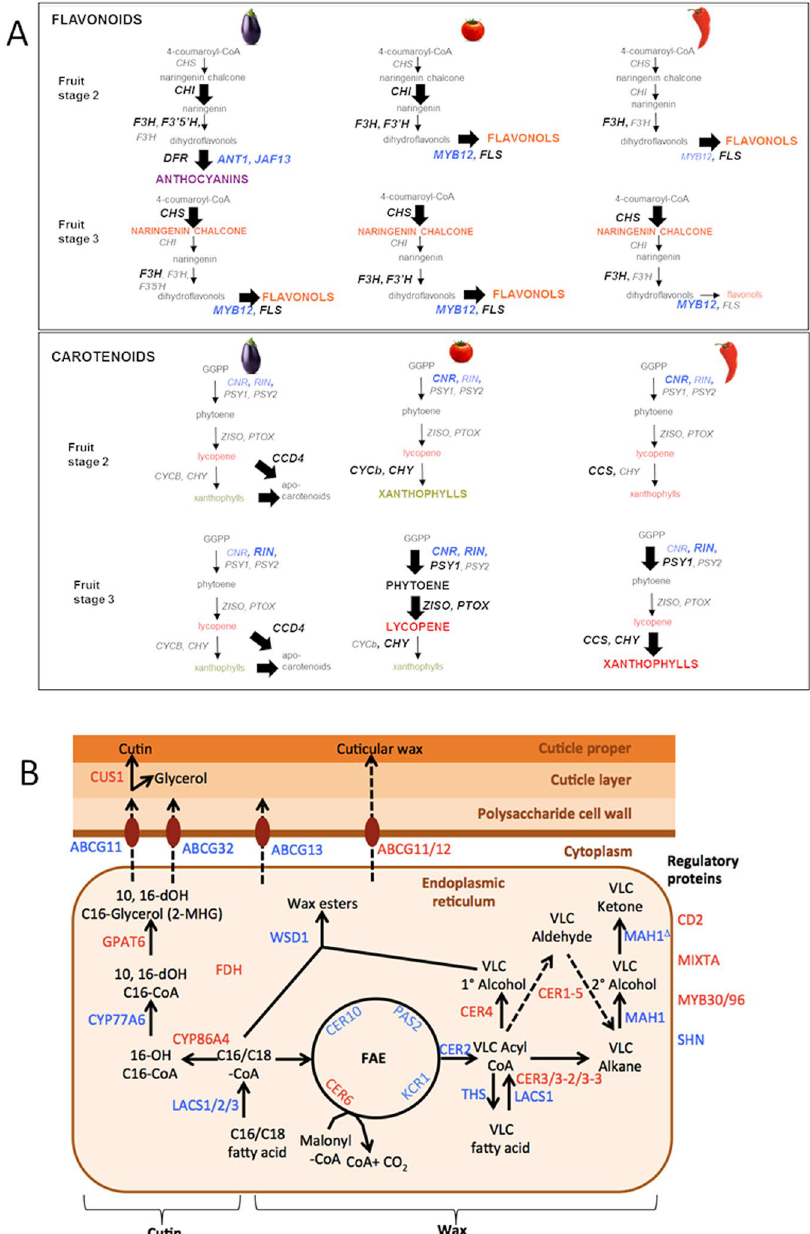
Figure 5. Control of fruit biochemical composition. ( A ) Schematic pathways for flavonoid (left) and carotenoid (right) biosynthesis in eggplant fruits. Genes and compounds overexpressed at each stage are shown in large bold character. Regulatory genes are indicated in blue. ( B ) Schematic cuticle biosynthesis pathway. Shortened gene names are indicated in blue. Genes showing fruit cuticle-enriched expression in both eggplant and tomato are indicated in